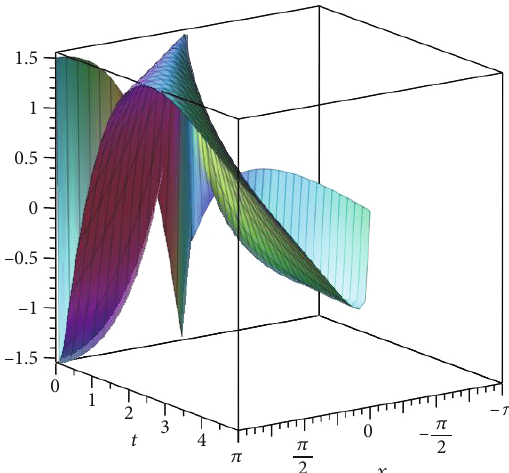
ð x , y , t Þ given by 1